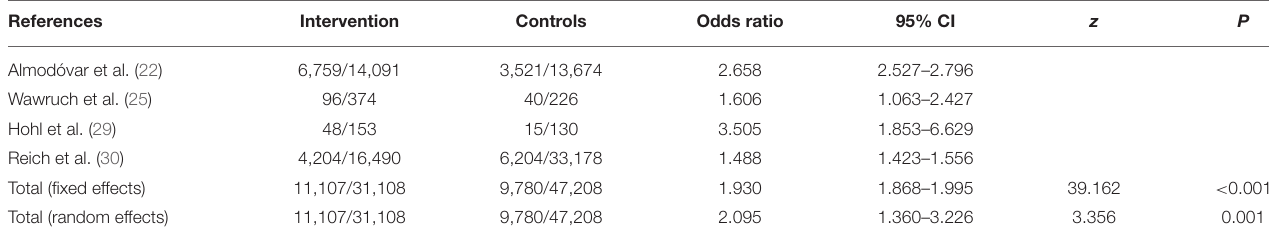
TABLE 3 | Results and odds ratios from the